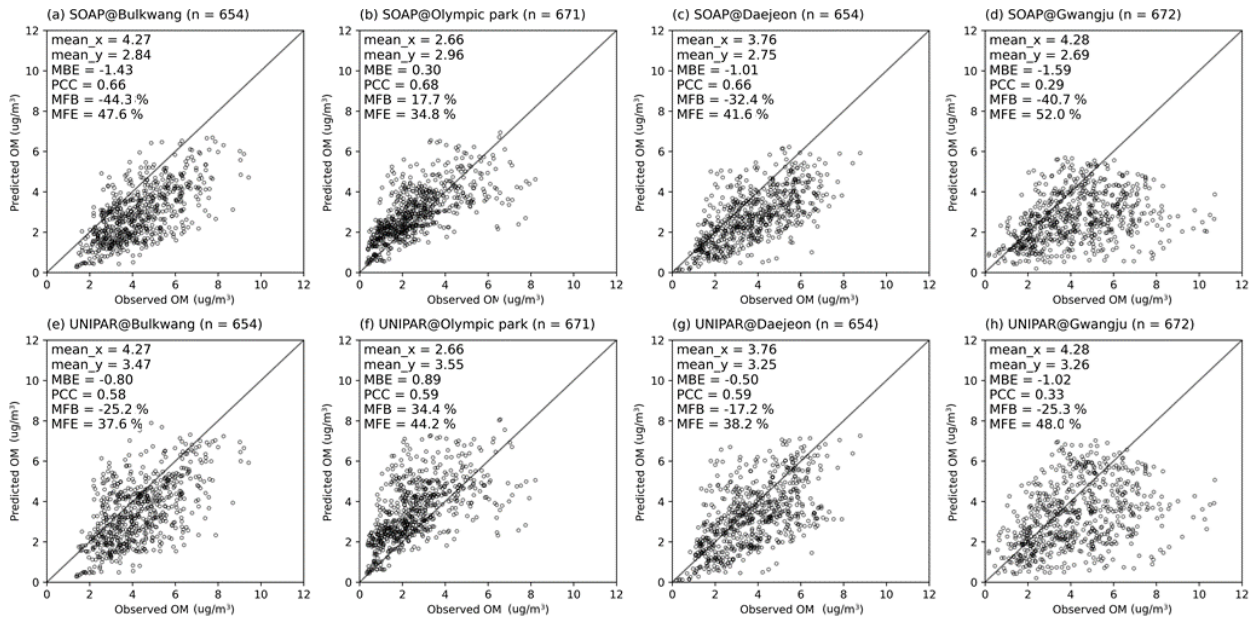
Figure 5. The observation of hourly averaged OM concentrations vs. CAMx simulation results by using the SOAP SOA module at the (a) Bulkwang, (b) Olympic Park, (c) Daejeon, and (d) Gwangju supersites and the results by using the UNIPAR SOA module at the (e) Bulkwang, (f) Olympic Park, (g) Daejeon, and (h) Gwangju supersites. “mean_x” and “mean_y” are the averaged OM concentrations of observations and predictions, respectively. “MBE” is the estimated mean bias error. “PCC” is the Pearson correlation coefficient. “MFB” and “MFE” are the mean fractional bias and mean fractional error,